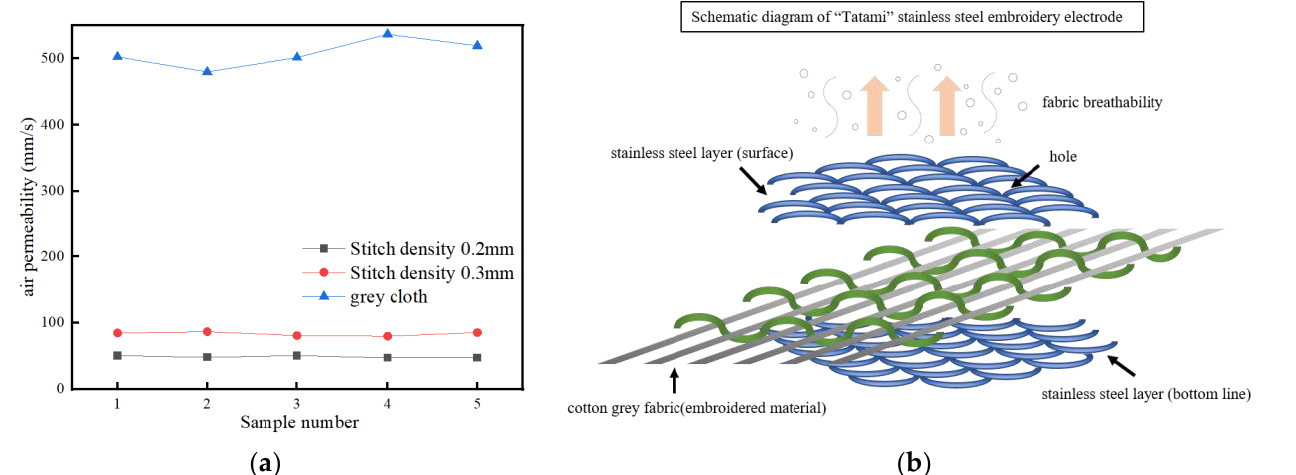
Figure 6. ( a ) Air permeability, broken line diagram, ( b ) electrode structure diagram of embroidery fabric.